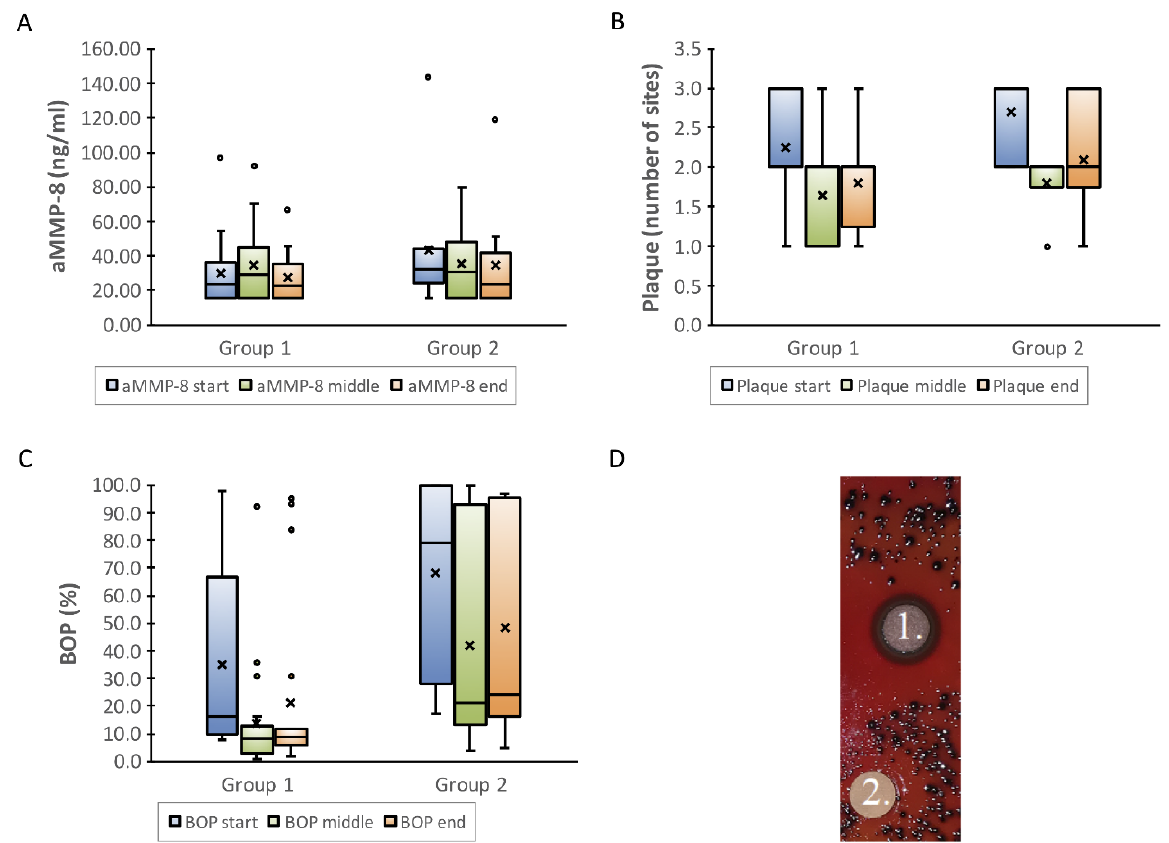
Figure 3. Inflammatory aMMP-8 and microbial visible plaque index (VPI), bleeding on probing (BOP) in vivo responses during fermented lingonberry juice (FLJ, Lingora ® ) mouthrinse trial. ( A ) aMMP-8, an oral fluid periodontal tissue destruction biomarker, represents and reflects inflammatory burden and periodontal disease activity, ( B ) VPI microbial burden and ( C ) BOP representing both inflammatory disease activity and microbial burden. Values of groups 1 and 2 at the start (0 d), middle (14 d, 7 d) and the end (28 d, 14 d). ( D ) Disc diffusion assay. Observed inhibition of P. gingivalis W50 growth with 100 µL FLJ (1.) compared to 10 µL 0.2% chlorhexidine (2.). Performed according to Pärnänen et al. [44]. The circles in the boxplots represent outlier values. “x” mean values.